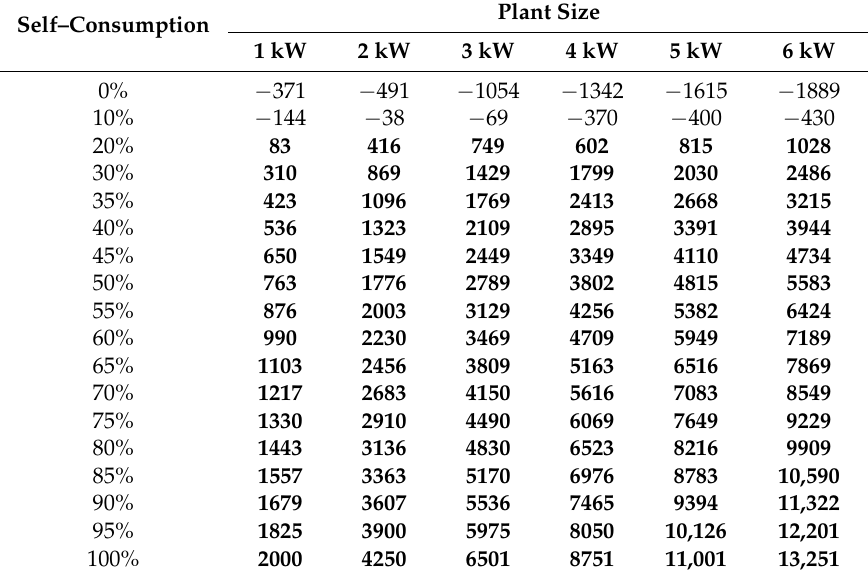
Net Present Value ( € ) of residential Net Present Value (PV) systems in function of